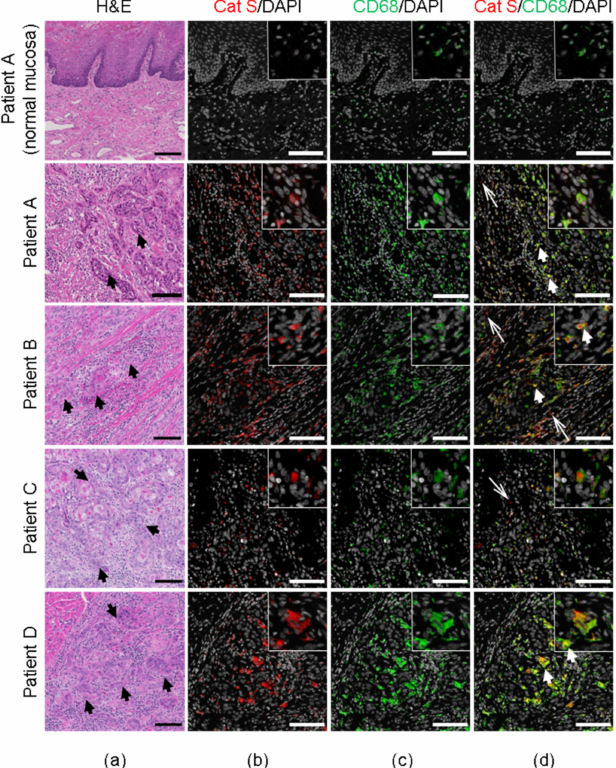
Figure 2. Localization of cathepsin S expression in macrophages associated with human oral cancers. ( a ) H&E staining of tongue tissue from four patients with tongue oral SCC, and adjacent normal tongue tissue section from one of the patients with oral SCC (Patient A) (Table 2). Black arrows in H&E sections indicate SCC. ( b ) Co-immunofluorescent staining of cathepsin S (Cat S, red) and DAPI (gray); ( c ) CD68 + macrophages (green) and DAPI (gray); ( d ) Cat S (red), CD68 + macrophages (green) and DAPI (gray). White thick arrows indicate cathepsin S in CD68 + macrophages; white thin arrows indicate cathepsin S in cancer microenvironment, but not in macrophages. Scale bars, 100 µ